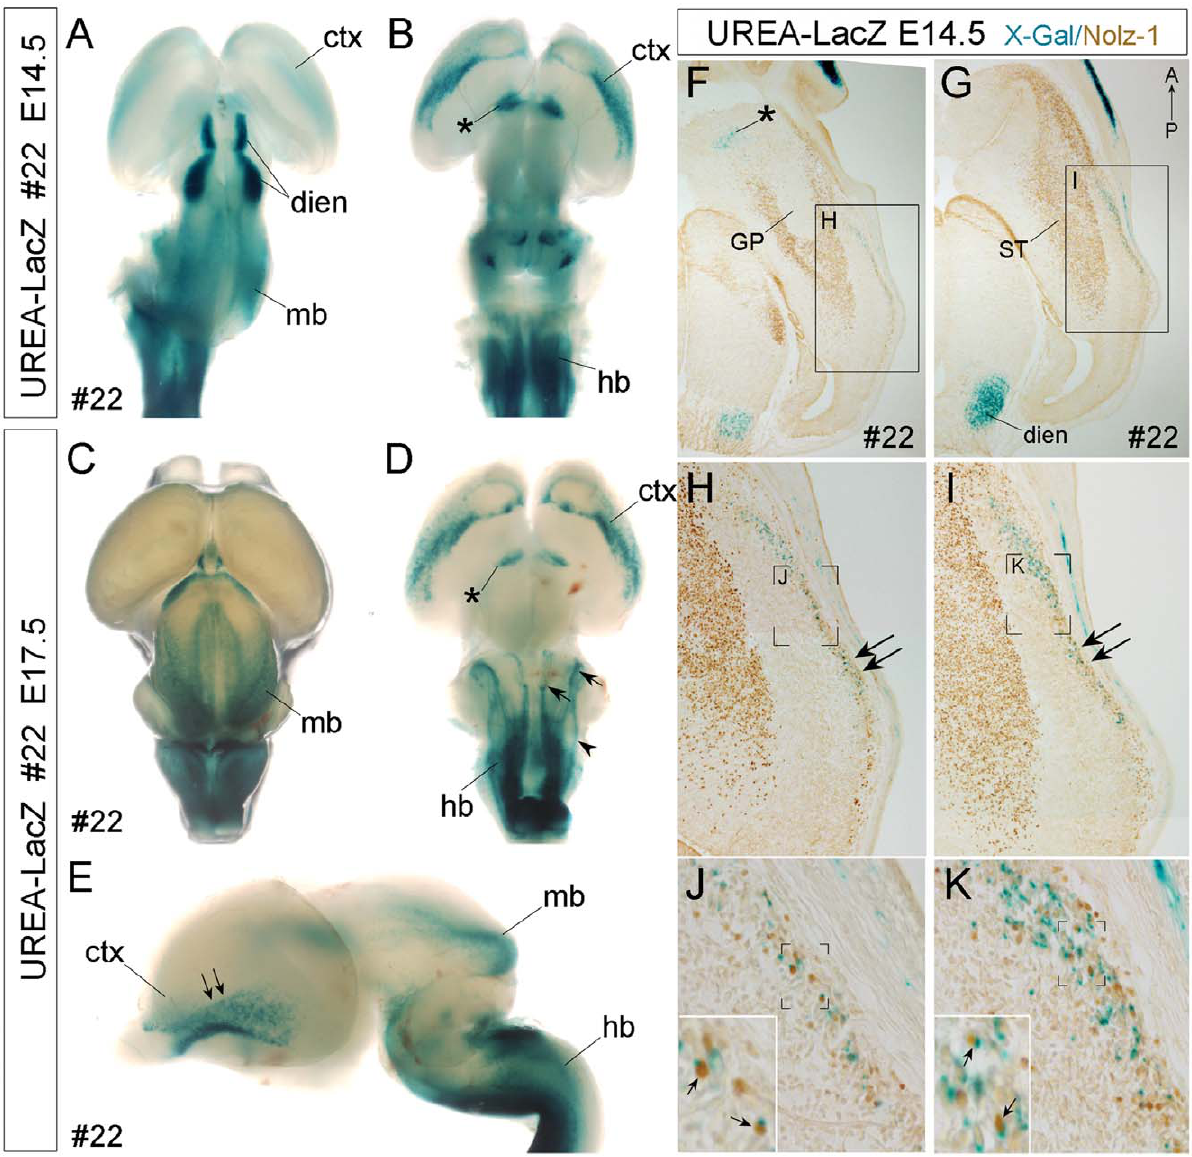
Figure 5. Detection of X-gal-positive signals in specific brain regions and LacZ + /Nolz-1 + cells in the ventral cortex of line # 22 UERA- LacZ embryos. A–E: Whole mount X-gal staining of E14.5 (A, B) and E17.5 (C–E) embryonic brains. X-gal-positive signals are detected in the cerebral cortex (ctx, B, D), ventral forebrain (asterisk, B, D), diencephalon (dien, A), midbrain (mb, A, C, E) and hindbrain (hb, B, D, E) regions. D: Three X-gal- positive longitudinal columns (arrowhead, arrows) are found in the hindbrain. The arrows indicate the X-gal-positive columns which are also observed in the hindbrain of line # 26 (Fig. S6), whereas the arrowhead indicates an additional X-gal-positive column found only in line # 22. E: The double arrows indicate the ventral-to-dorsal gradient of X-gal-positive signals in the ventral cortex. A, C: dorsal view; B, D: ventral view; E: lateral view. F–K: Double labeling of X-gal-positive signal and Nolz-1 protein on E14.5 horizontal forebrain sections of line # 22 UREA-LacZ embryos. Nolz-1 is expressed in the striatum (ST), but not in the globus pallidus (GP), nor in the X-gal-positive domains in ventral forebrain (asterisk, F) and diencephalon (dien, G). In the lateral cortex, a stream of X-gal-positive cells is observed. Within this cell stream, many X-gal-positive cortical cells co-expressing Nolz- 1 (small arrows in insets of J, K) are detected. Anterior is to the top of figures F–K. Figure F is at ventral level and Figure G is at more dorsal level. The boxed regions in F, G and the bracketed regions in H, I, J, K are shown at high magnification in H, I, J, K, and insets in J, K, respectively. IV, fourth ventricle; mb, midbrain. respectively) of E14.5 UREB-LacZ embryos (Figure S7D–I). The X-gal-positive signals were also detected in the adrenal gland in line # 28 and # 81 (Figure S7D, E, G, H). Double labeling of Nolz-1 protein and X-gal showed that Nolz-1 was co- expressed in some X-gal-positive ureteric tubules of developing kidney (Figure 8B–D).